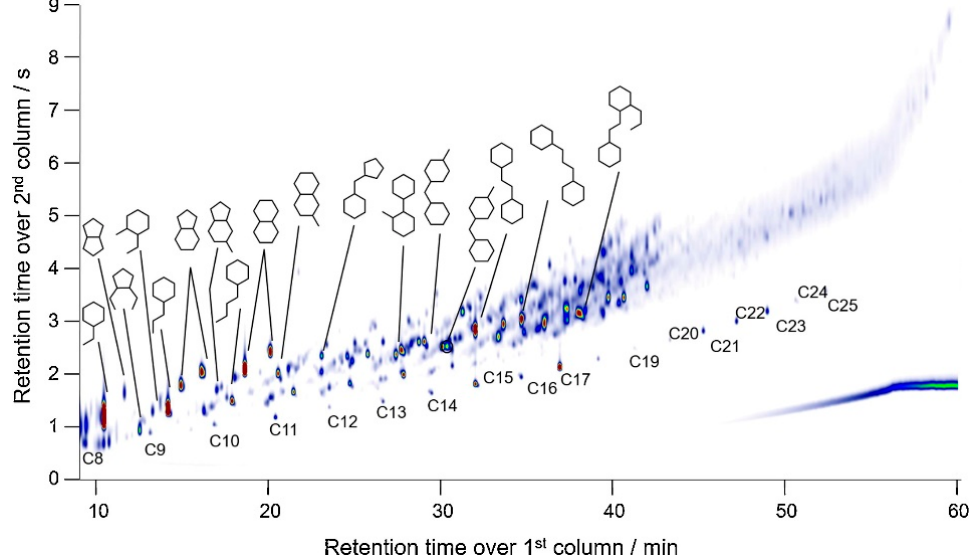
Figure 12. GC-MS image of the products obtained from the HDO of organsolv lignin for ref [33] .